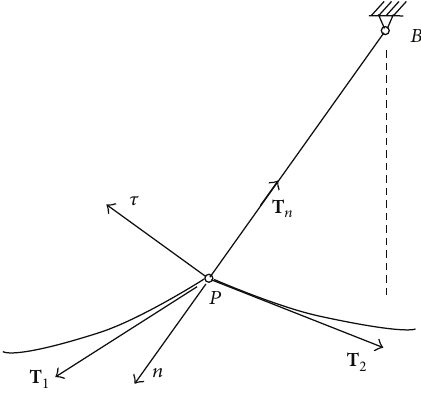
Figure 2: The forces at the suspension